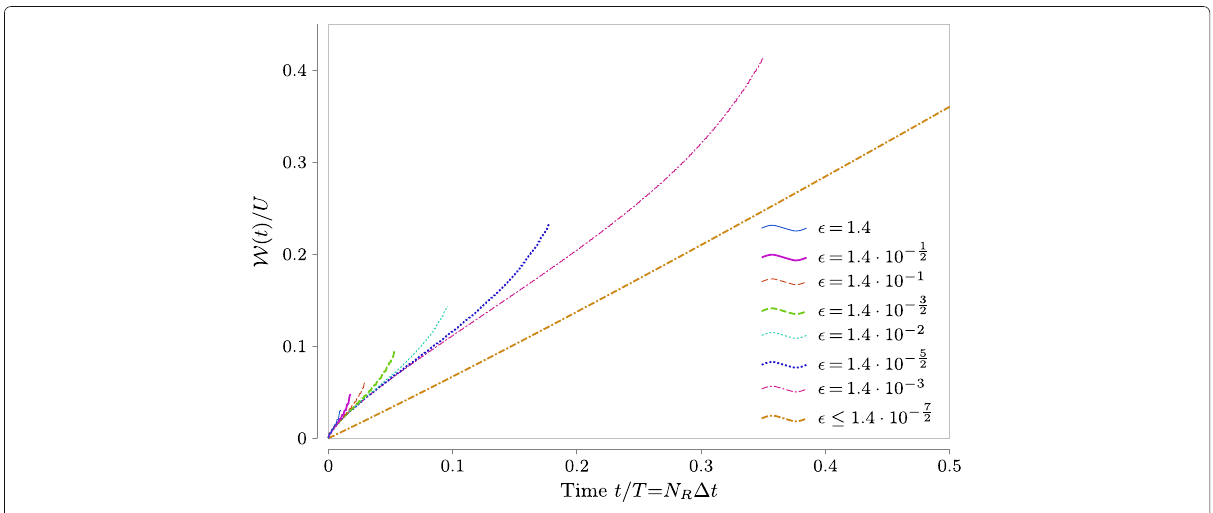
Fig. 5 A plot of W ( t ) in System D at different parameter values of (cid:14)